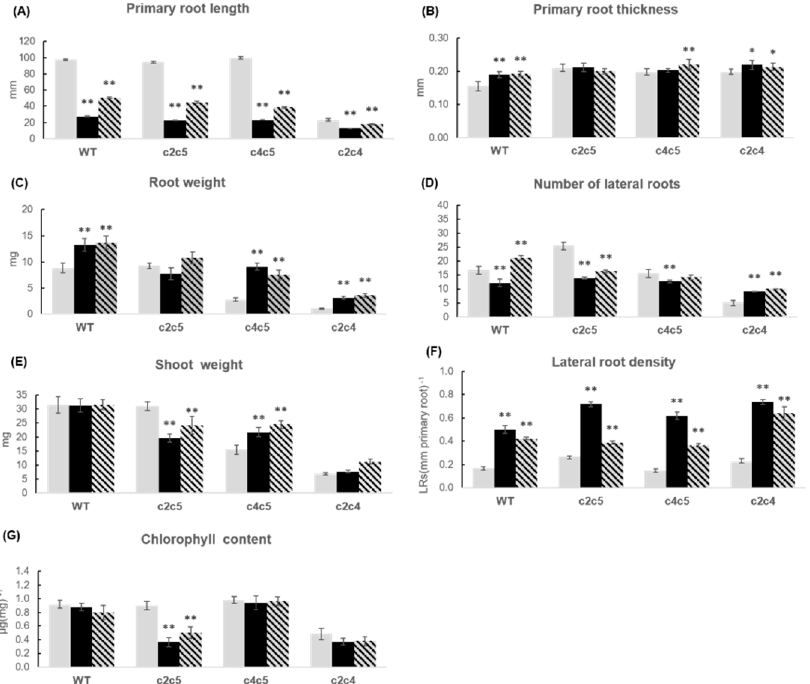
Figure 10. Growth parameters of WT and double mutants treated with A. brasilense . Growth parameters of WT and double mutants c2c5 , c4c5 , c2c4 cultivated without bacteria (white bars), with A. brasilense Sp245 (black bars) and with A. brasilense FAJ0009 (hatched bars) for two weeks. ( A ) primary root length; ( B ) primary root thickness; ( C ) root fresh weight; ( D ) number of lateral roots; ( E ) shoot fresh weight; ( F ) lateral root density; and ( G ) chlorophyll content. For root length, primary root thickness, number of lateral roots, and root density, data are means ± SE of 30 plants ( n = 30). For fresh weight and chlorophyll content, the plants in each plate were pooled for measurements, and data given is the average of six independent experiments, n = 6, ± SE is given. The root and shoot weights ( C ) and ( E ) represent single plant averages. The chlorophyll values ( G ) represent µ g chlorophyll per mg leaf tissue. According to Student’s t -test and p -value < 0.05, columns marked with two asterisks are significantly different from the control without bacteria, and for one asterisk with p <